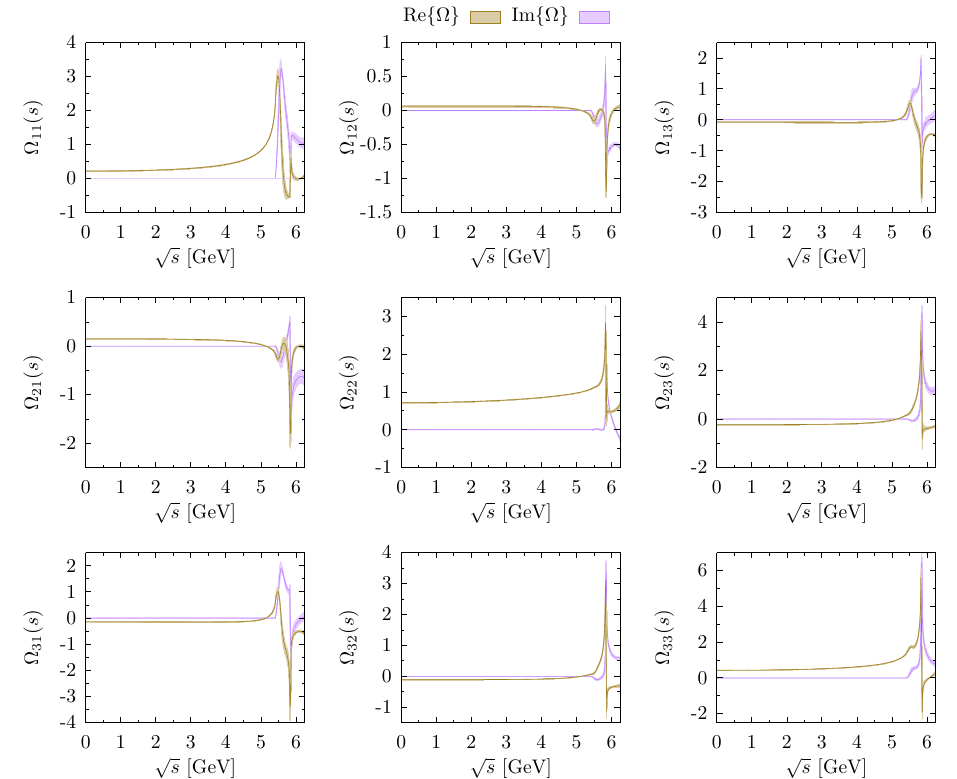
Fig. 6 Bottom ( S , I ) = ( 0 , 1 / 2 ) Omnès matrix solution of the MO integralequation(20)withthecontourcondition (cid:15)